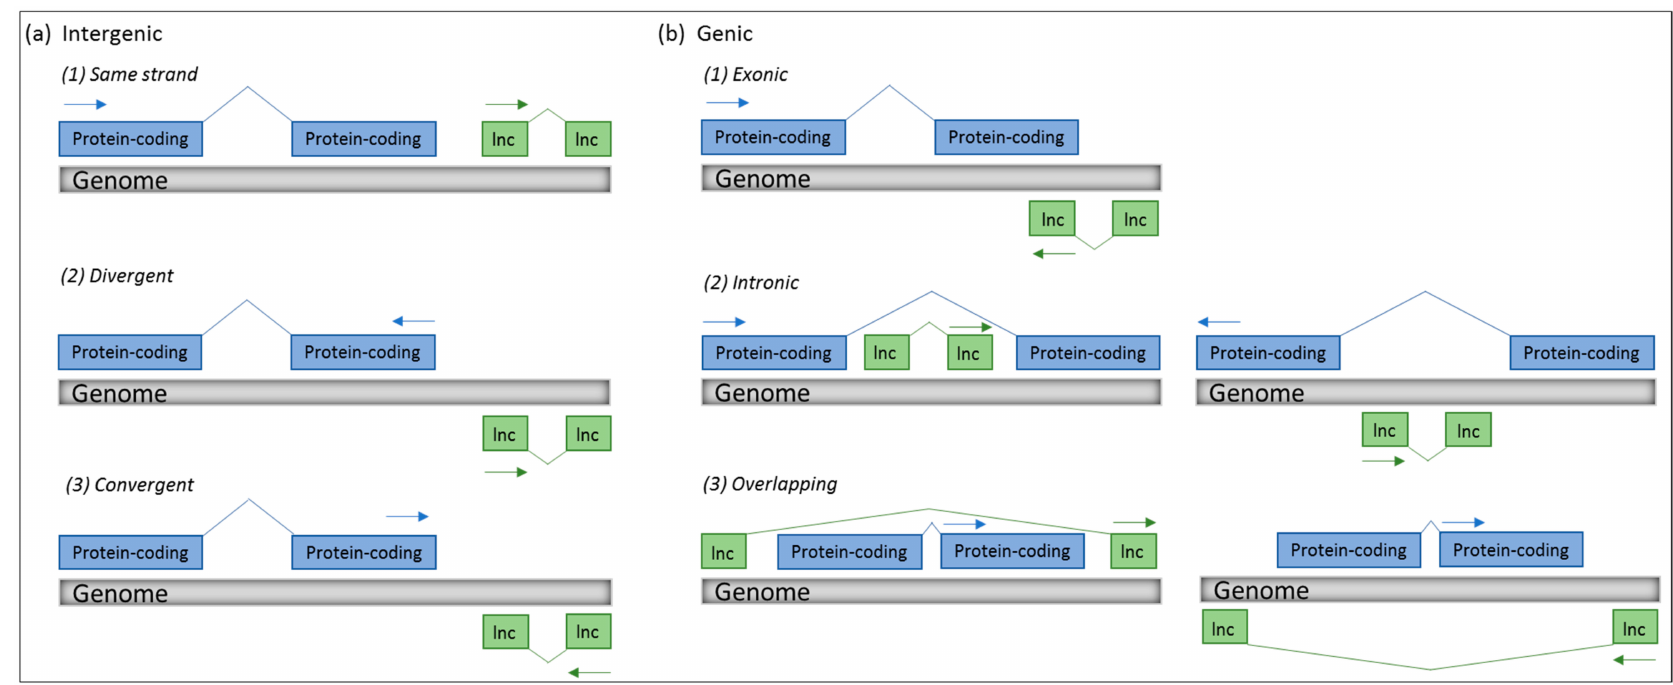
Figure 1. Positional classification of long non-coding RNAs (lnc) according to the GENCODE v7 catalogue of human long non-coding RNAs. ( a ) Intergenic long non-coding RNAs (lncRNAs) are located in between two independent genes and can be transcribed either from the same strand (1) or antisense in a divergent (2) or convergent (3) manner. ( b ) Genic lncRNAs are subdivided into: (1) exonic lncRNAs that intersect a protein-coding gene by at least 1 bp, (2) intronic lncRNAs that reside within the intron of a protein coding gene as either sense or antisense, and (3) overlapping lncRNAs that contain a protein-coding gene within an intron, as either sense or antisense. All antisense transcripts can be transcribed in a head-to head manner, as shown in (2), or in a tail-to-tail manner, as shown in (1). Arrows indicate direction of transcription of the protein-coding gene (blue) or the lncRNA (green). A final category is termed “processed transcript”, and this is used when the locus does not contain an open reading frame, but it does not fall into any of the other